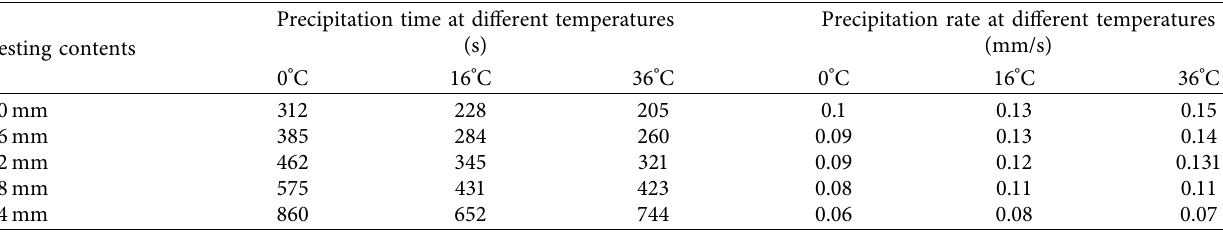
Table 6: Precipitation time and speed of clay Slurry.